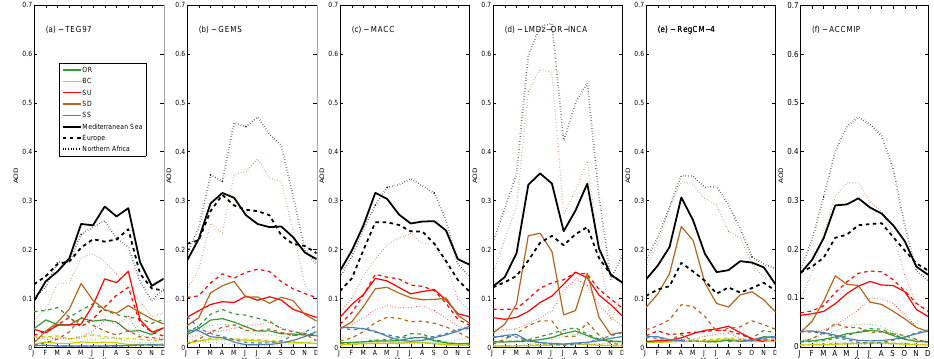
Fig. 8. Mean Aerosol Optical Depth (AOD) at 550 nm for each aerosol type (SD = soil dust, BC = black carbon, OR = organic carbon, SU = sulfates and SS = sea-salts) simulated by different models over the Mediterranean region. Averages are calculated over Northern Africa (dotted line), the Mediterranean Sea (continuous line) and Europe (dashed line). The black lines plot the total AOD for the different regions. for studies over the Mediterranean basin. The generation 950 module of RegCM-4 for dust and sea-salt aerosols at a high